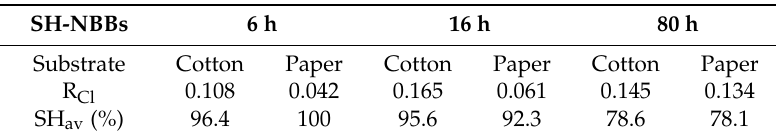
Table 1. Summary of the values of R Cl and SH av (%), as calculated from the 1 H NMR spectra of SH-NBB_c and SH-NBB_p